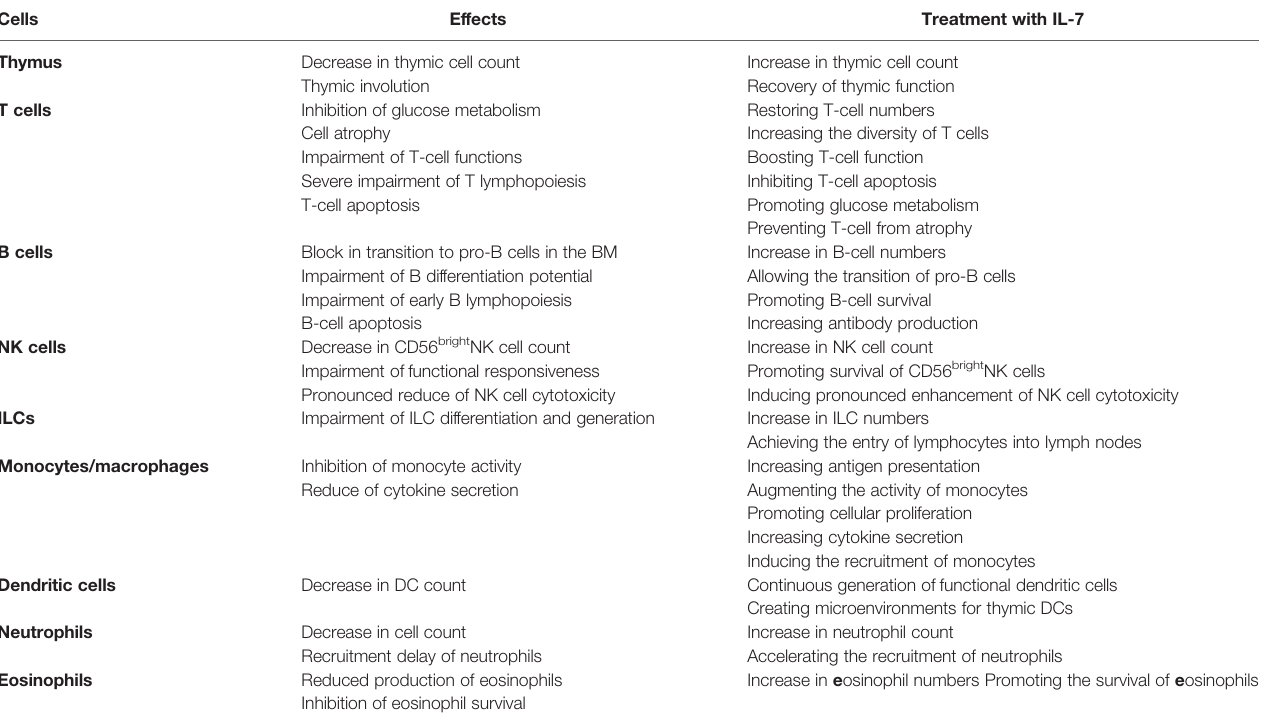
TABLE 1 | The effects of de fi ciency of IL-7 and its receptor on development of immune cells.